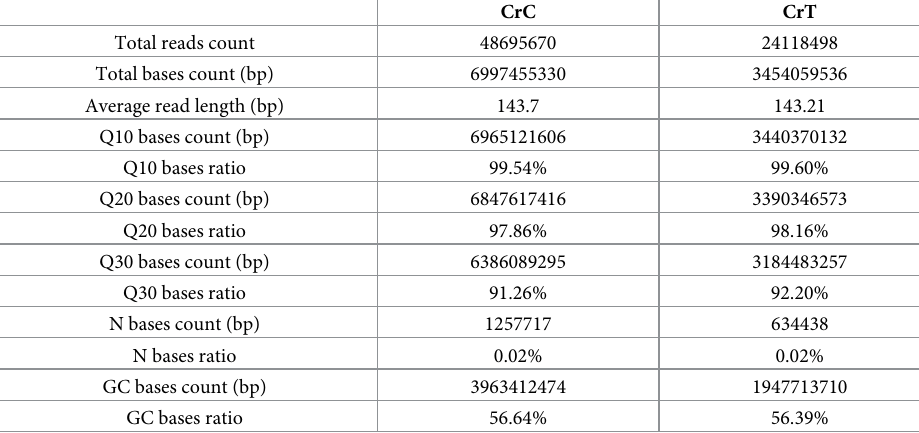
Table 1. Sequencing data for CrC and